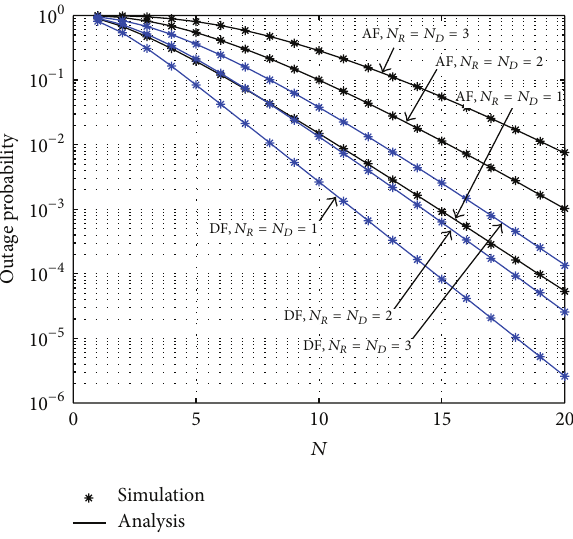
Figure 4: Outage probability of the DF relaying system with MRT versus SNR.